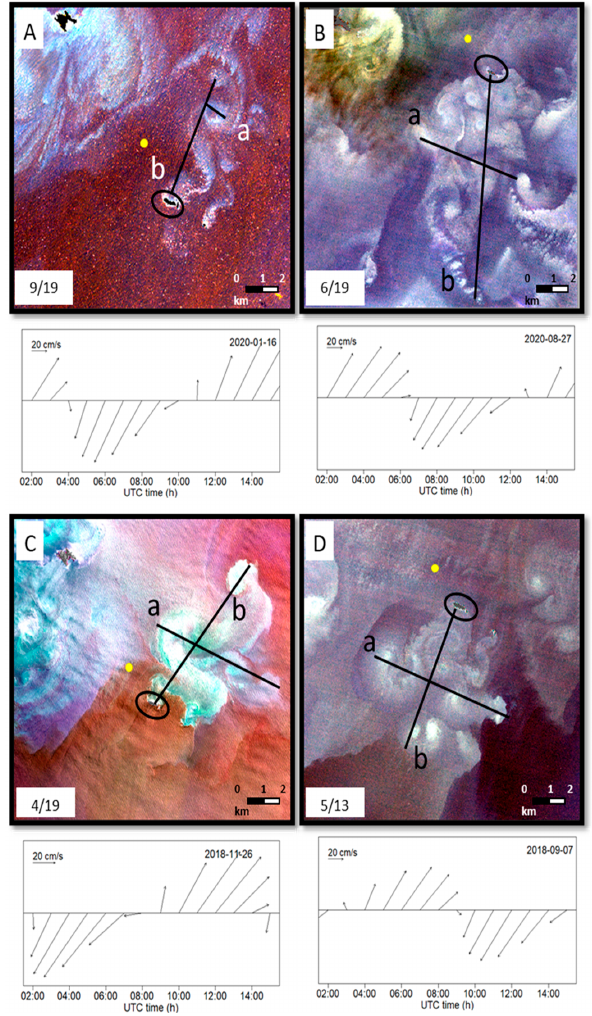
Figure 4. Structures in Rasa Island (inside the black circle). ( A ) Associated eddies chain north of Rasa Is., rotating clockwise, after 4 h of NNE tidal current. ( B ) Associated eddies chain south of Rasa Is., rotating clockwise, after 1 h of N tidal current. ( C ) Associated eddies chain north of Rasa Is., with both rotating directions, after 6 h of NE tidal current. ( D ) Associated eddies chain of Rasa Is., rotating clockwise, after 5 h of SW tidal current. Black lines indicate how the structures were measured, being (a) width of associated eddies chain and (b) distance from Rasa Island. Numbers in the lower left corner represent the number of scenes showing this particular structure (linked with Table 2). The arrow time series below each image represents the tidal current velocities 12 h prior to the acquisition of the image as extracted from TPXO data at the locations marked by yellow points in the corresponding